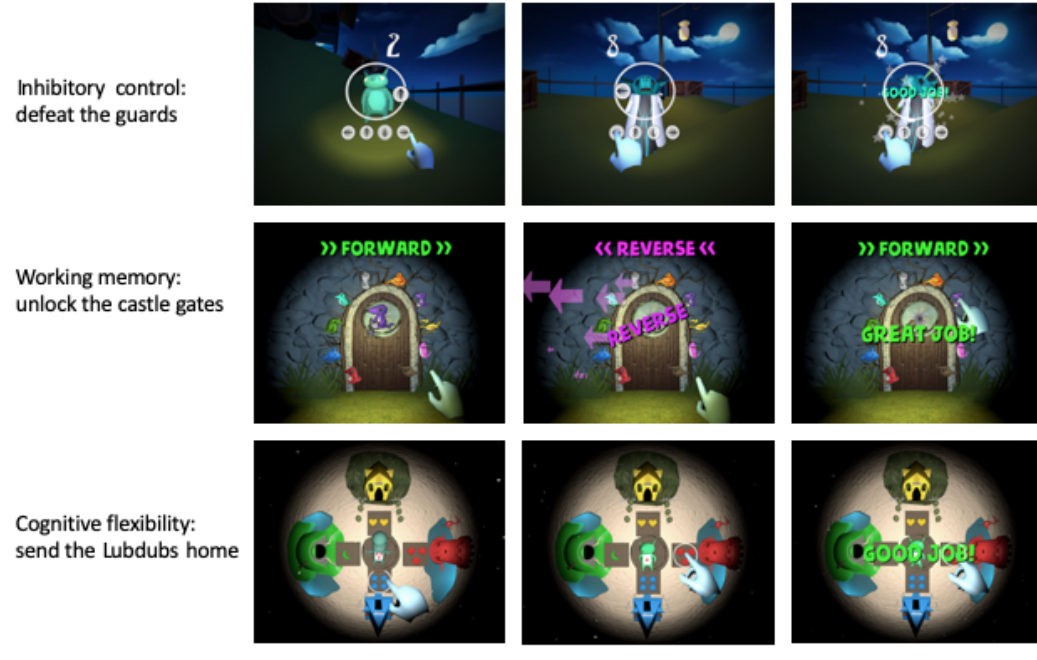
Figure 4. Virtual reality–based interactive cognitive training modules. (Top panel) inhibitory control, (middle panel) working memory, and (bottom panel) cognitive